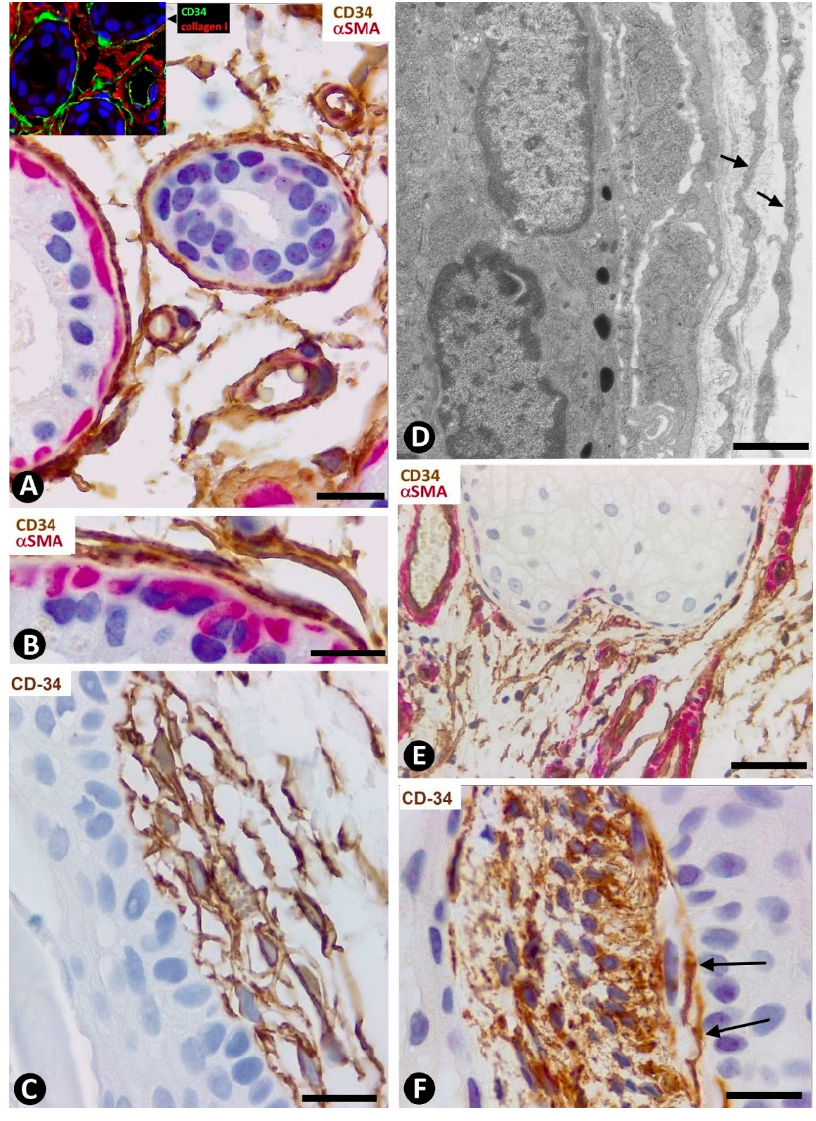
Figure 3. CD34+SCs/TCs around sweat glands, hair follicles and sebaceous glands. ( A , B , E ) Double immunochemistry for CD34 (brown) and α SMA (red). Hematoxylin counterstain. ( C , F ) Immuno- chemistry for CD34. Hematoxylin counterstain. ( D ) Ultrathin section. Uranyl acetate and lead citrate. ( A , B ) CD34+SCs/TCs (brown) are observed around the sweat glands at different magnifi- cations. Myoepithelial cells are stained red. ( C ) Several layers of CD34+SCs (brown) around a hair follicle. ( D ) Ultrastructural image of telopodes of two telocytes (arrows) surrounding a hair follicle. ( E ) CD34+SCs/TCs (brown) around a sebaceous gland. ( F ) A cluster of very small, densely grouped CD34+ stromal cells with multiple intricate processes between the bulge region of a hair follicle and a sebaceous gland. Note CD34+SCs/TCs (arrows) interposed between the cluster of small CD34+ stromal cells and the hair epithelium. Bar; ( A – C , F ) 25 µm, ( D ) 3 µm, ( E ) 80 µm.